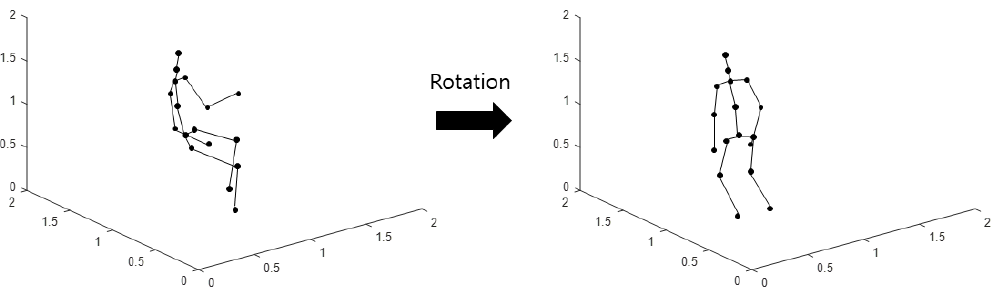
Figure 3. Schematic diagram of rotation of the skeleton.